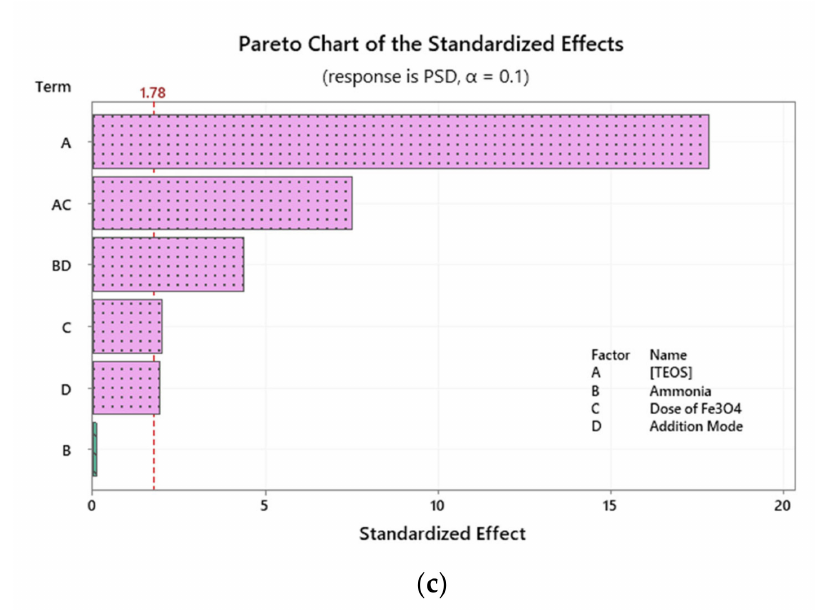
Figure 1. Pareto chart of standardized e ff ects for the three measured responses. Data in each panel were obtained following response transformation. ( A ) Response is magmatic properties; ( B ) Response is PS (nm); ( C ) Response is